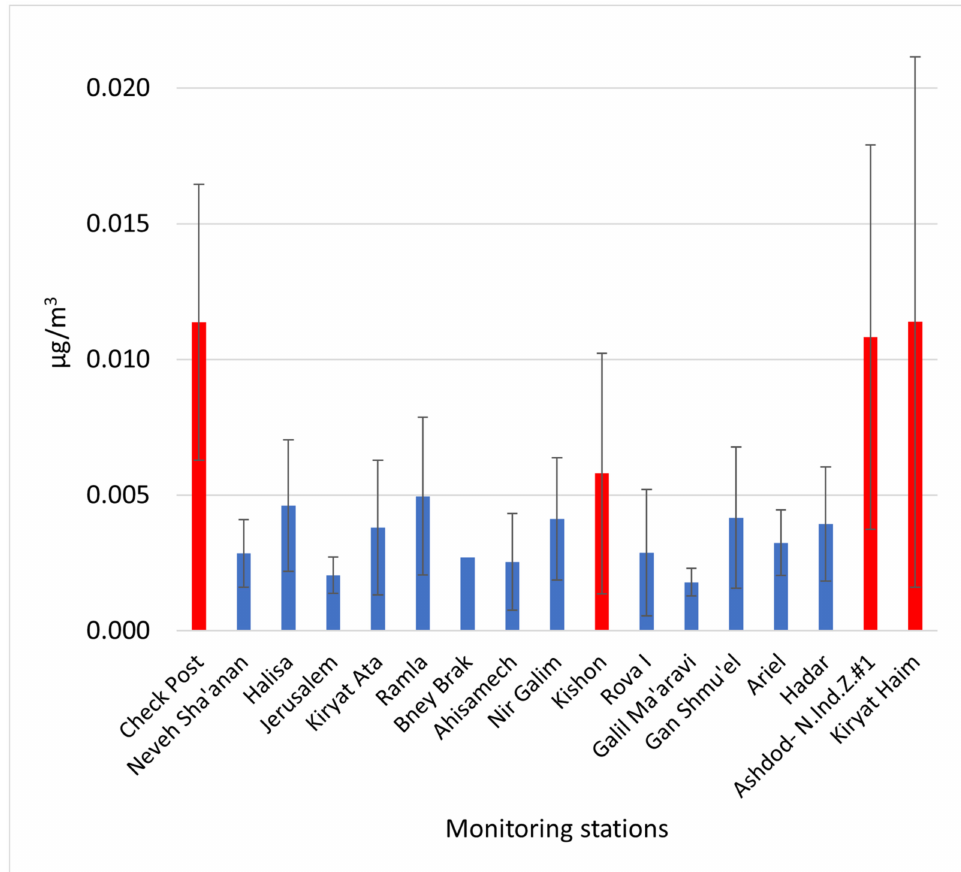
Figure 4. Average 2018 nickel concentration as a fraction of TSP (total suspended particulate) in Israeli air quality monitoring stations. The Y axis is an average concentration of nickel as a fraction of TSP in µ g/m 3 of air. Red: monitoring stations with an average nickel concentration over 0.005 µ g/m 3 ; blue: monitoring stations with an average nickel concentration under 0.005 µ g/m 3 . Error bars represent standard